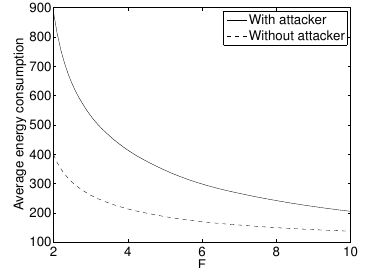
Figure 9: Comparison of R with or without attacker. Strategy 2